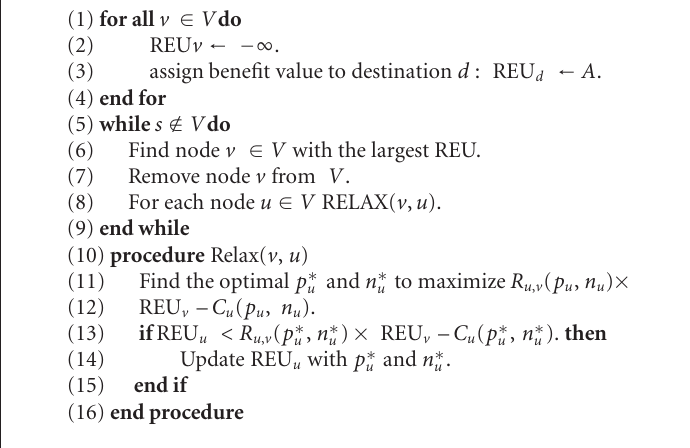
Algorithm 1: Unicast( V , s , d , A